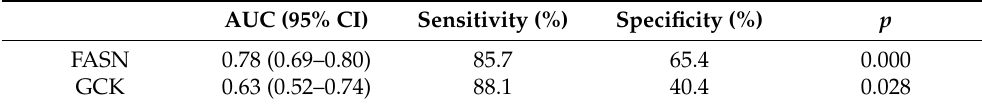
Figure 9. mRNA levels of FASN and GCK and the methylation level of FASN . ( A ) mRNA levels of FASN and GCK . ( B ) The methylation level of FASN . ( C ) Spearman correlation analysis between mRNA levels of FASN and methylation level of FASN in all participants. * p < 0.05. Table 2. The diagnostic capability of FASN and GCK m RNA for